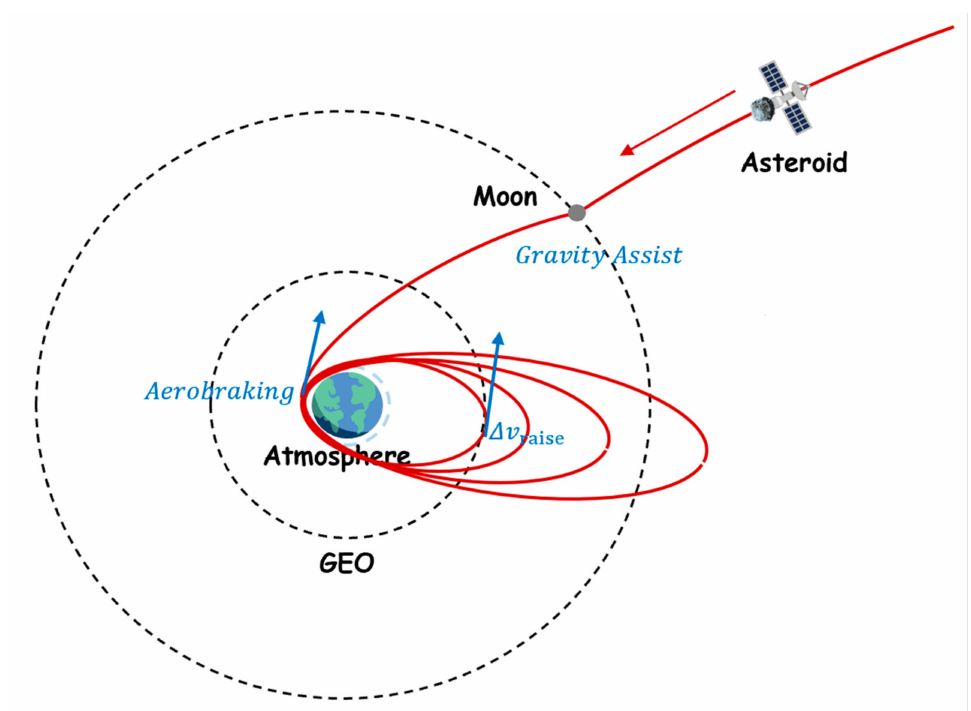
Figure 2. Schematic diagram of lunar flyby plus Earth aerobraking, used to capture an asteroid.